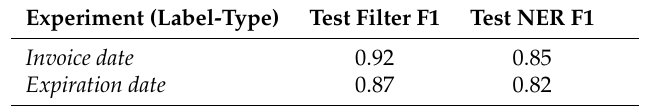
Table 5. Results in terms of F1 scores of the segment filtering and NER sequence labeling ( Without transfer